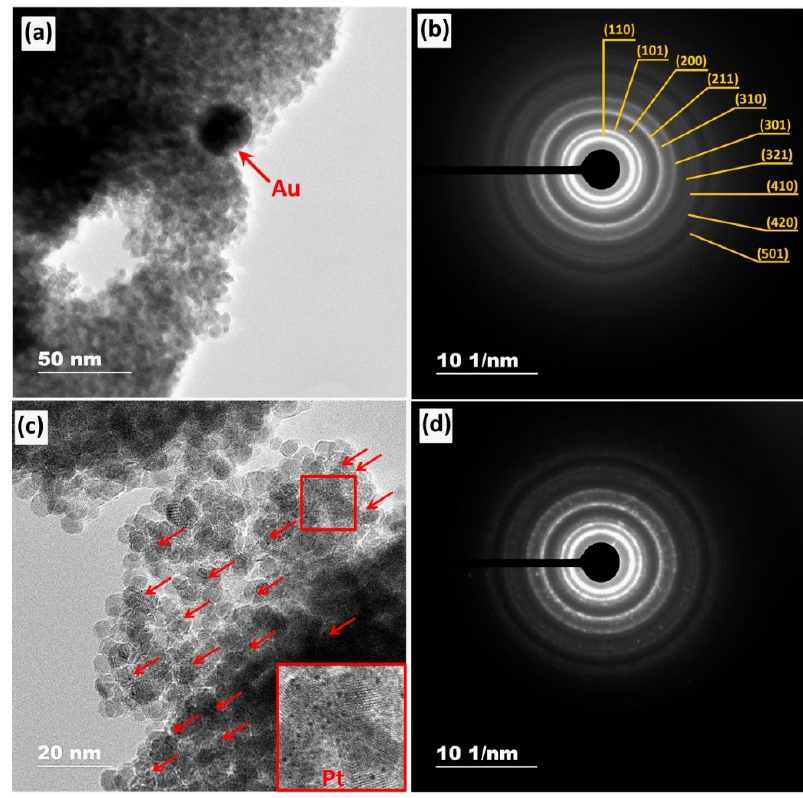
Figure 2. TEM images and their corresponding SAED patterns of SnO 2 /TiO 2 @Au ( a ) and ( b ) and SnO 2 /TiO 2 @Pt ( c ) and ( d ) nanocomposites. Pt nanoparticles are marked with red arrows ( c ).